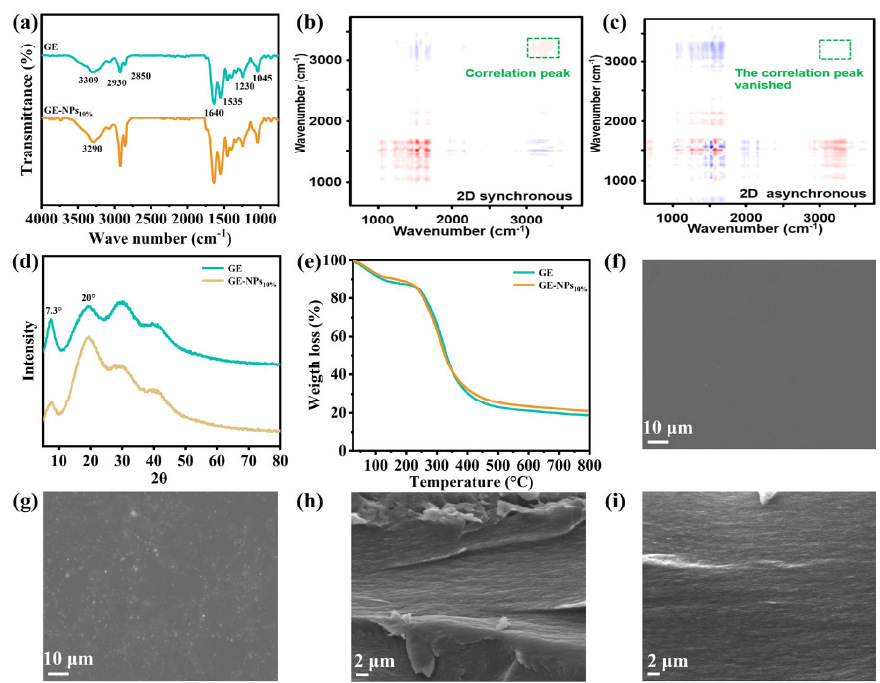
Figure 2. ( a ) FTIR spectrum of GE coating and GE-NPs 10% coating; ( b , c ) 2D correlation FTIR synchronous and asynchronous spectra of GE-NPs 10% coating; ( d ) XRD spectrum of GE coating and GE-NPs 10% coating; ( e ) TGA spectrum of GE coating and GE-NPs 10% coating; ( f , g ) SEM images of the surface of GE coating and GE-NPs 10% coating; ( h , i ) SEM images of the cross-section of GE coating and GE-NPs 10% coating.